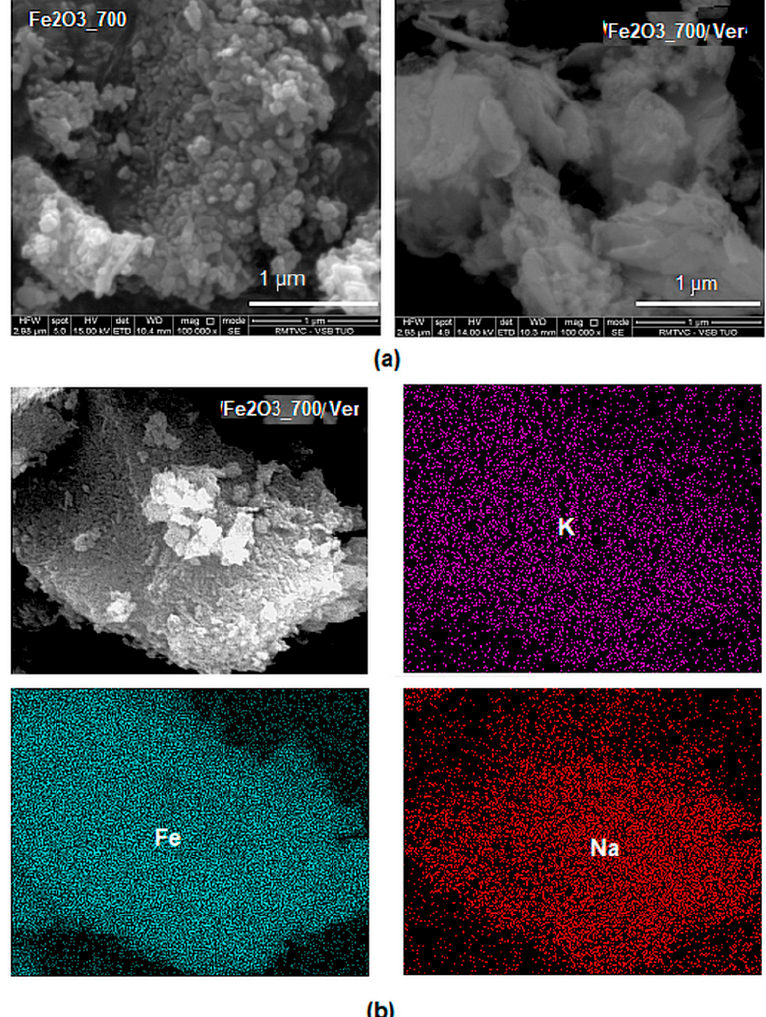
Figure 3. Backscattered electron (BSE) images: ( a ) α -Fe 2 O 3 nanoparticles after precipitation in water solution and an aqueous dispersion of vermiculite (sample α -Fe 2 O 3_ 700/Ver) calcined at 700 °C; ( b ) EDS maps of elements Fe, K and Na on the surface of vermiculite flake α -Fe 2 O 3 _700/Ver.